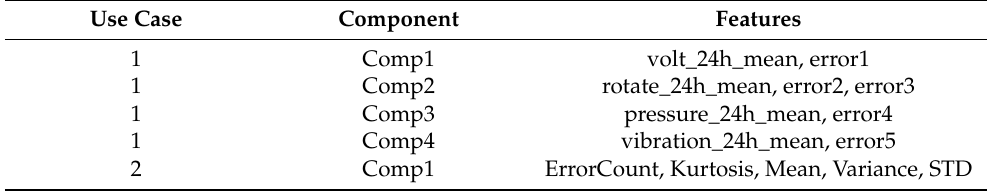
Table 2. Selected features for Use Case 1 and